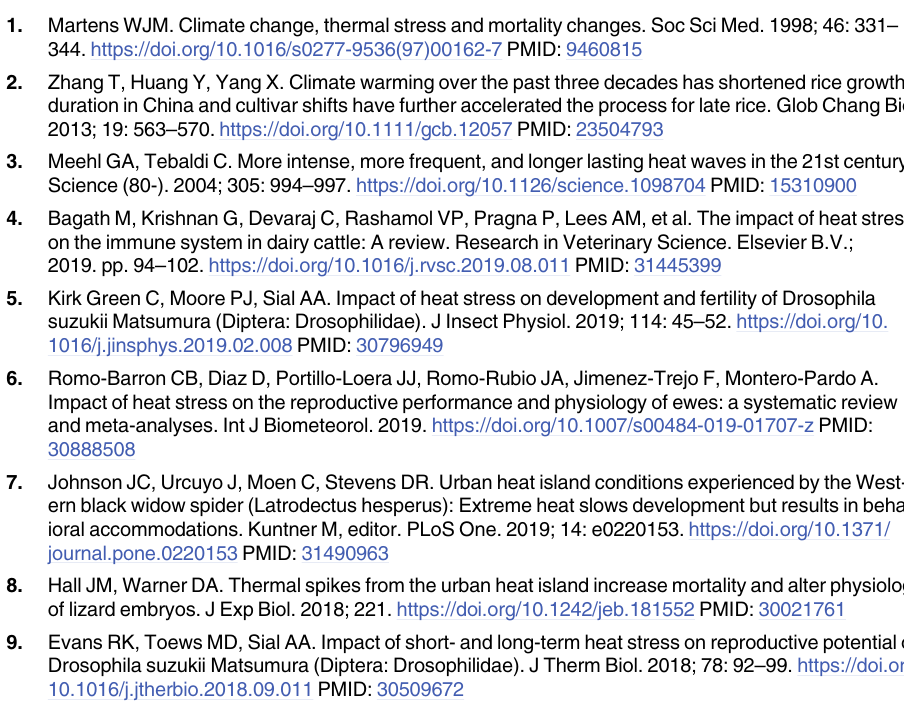
S1 Table. Spider ecdysteroid and developmental